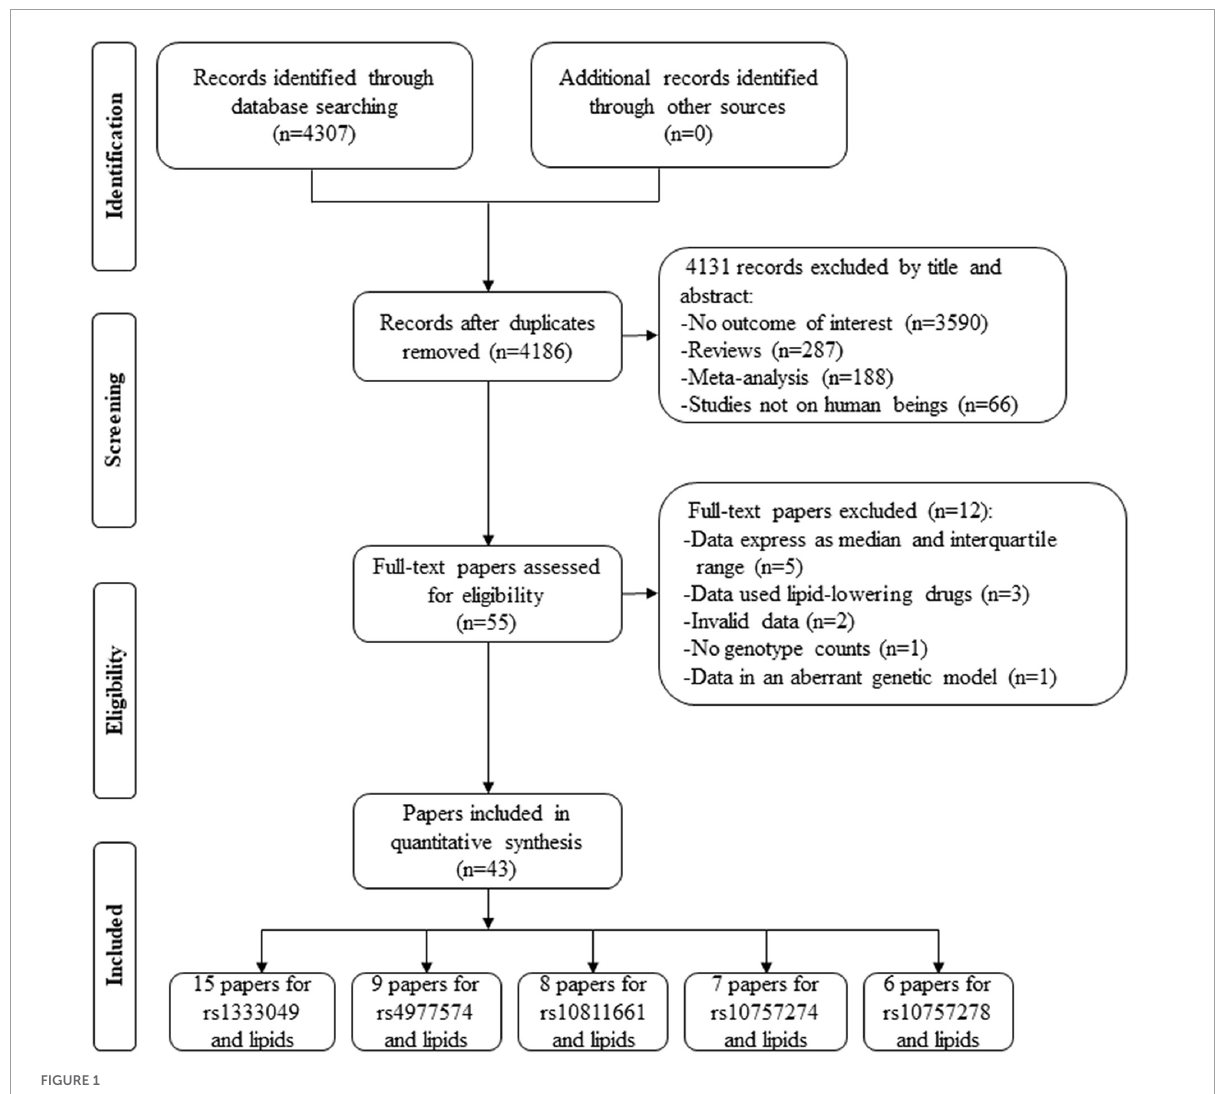
FIGURE1 A flow diagram of the study’s selection